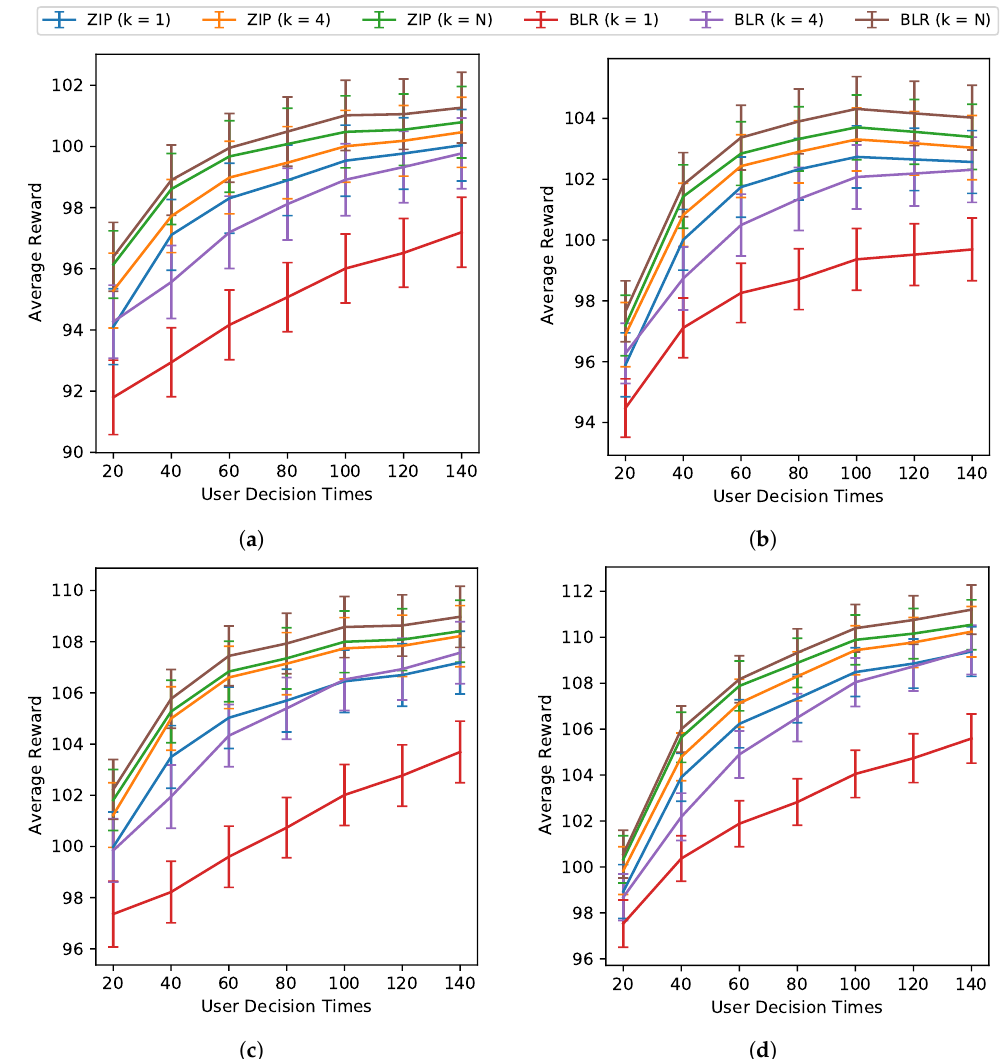
Figure 3. Average User Rewards Over Time. Above, we show simulation results of the six can- didate algorithms (BLR and ZIP respectively for different cluster sizes k ) across the four simula- tion environments. The y-axis is the mean and ± 1.96 · standard error of the average user rewards 1 ∑ 72 ∑ t 0 R i , s ) for decision times t 0 ∈ [ 20,40, 60,80,100, 120,140 ] across 100 Monte Carlo ( ¯ R = 1 i = 1 t 0 s = 1 72 simulated trials. Standard error is ˆ σ √ where ˆ σ is the sample variance of the 100 ¯ R s. ( a ) Stationary 100 Base Model and Heterogeneous Effect Size; ( b ) Nonstationary Base Model and Heterogeneous Ef- fect Size; ( c ) Stationary Base Model and Population Effect Size; ( d ) Nonstationary Base Model and Population Effect